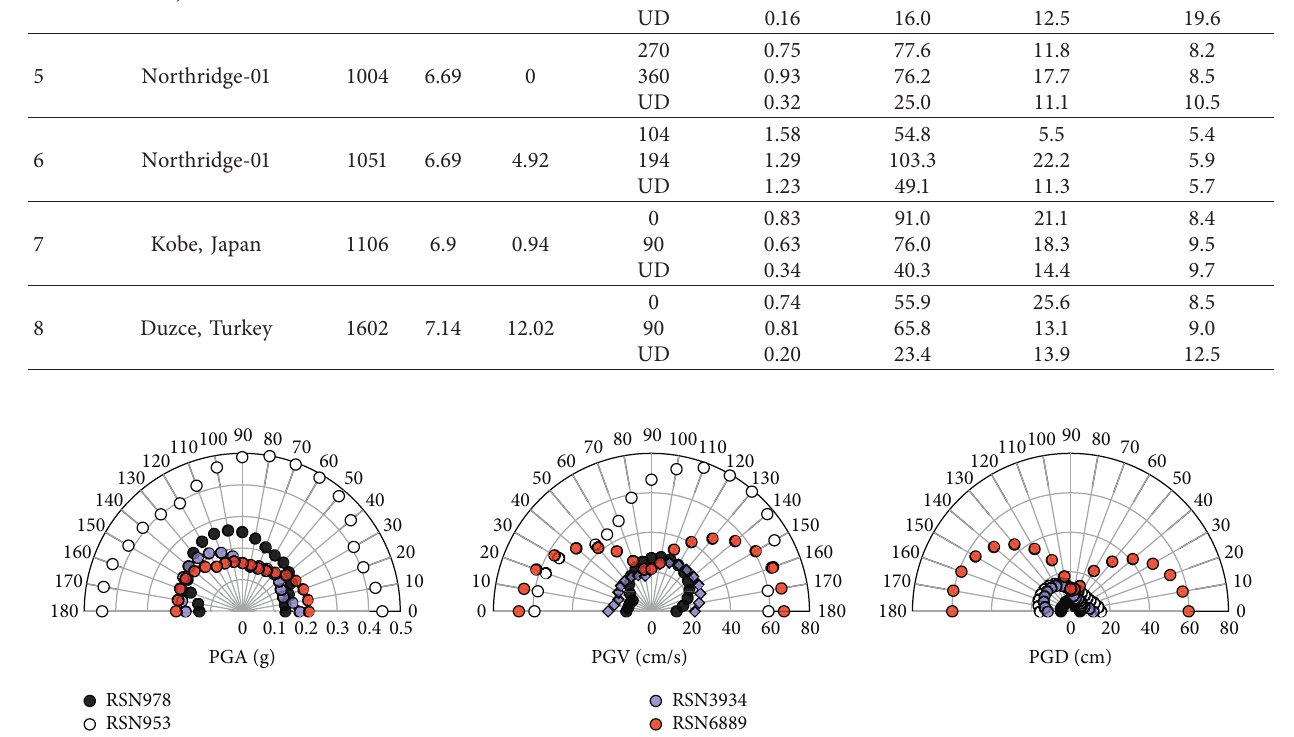
Figure 3: The peak values of non-pulse-type ground motions varied with orientation.